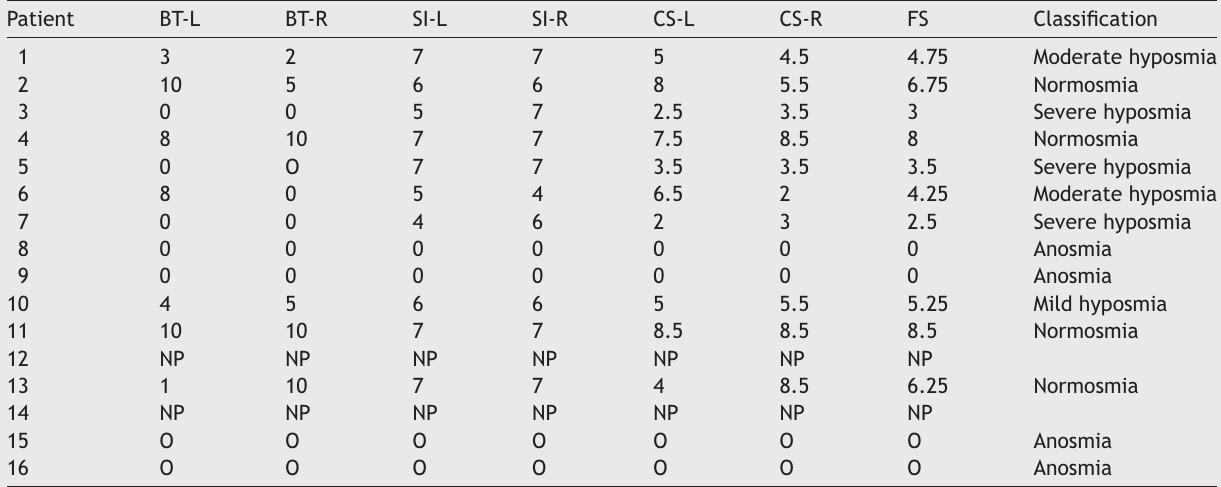
Result of the Connecticut Chemosensory Clinical Research Center olfactory test after surgical